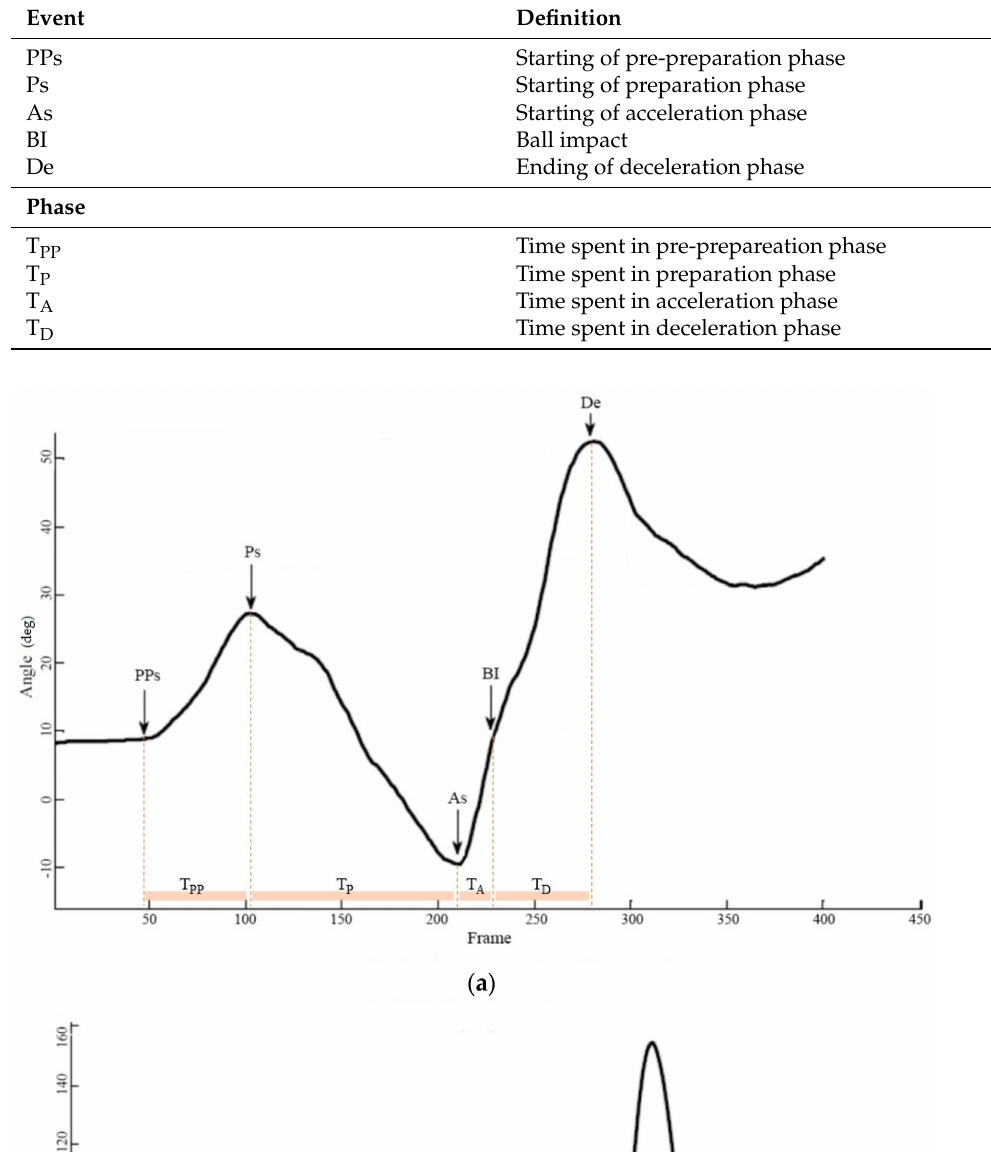
Table 3. Definition of event and phase on the signal waveform.